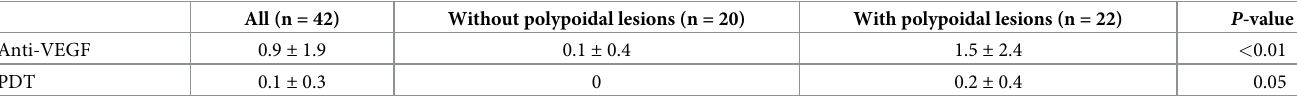
Table 2. Total number of additional treatments during the 12-month follow-up. All (n = 42) Without polypoidal lesions (n = 20) With polypoidal lesions (n = 22) P -value Anti-VEGF